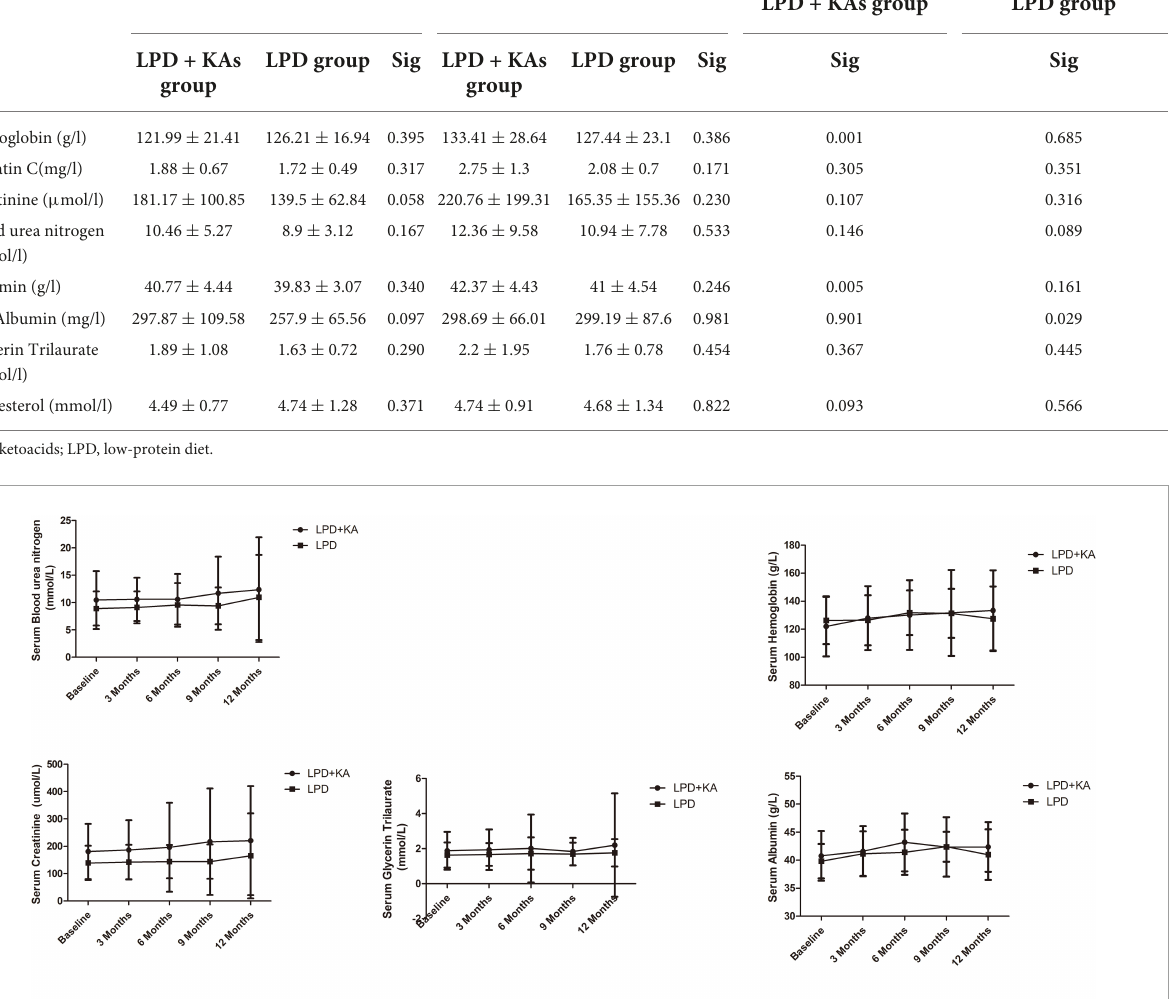
Pair-comparison- LPD + KAs group LPD group